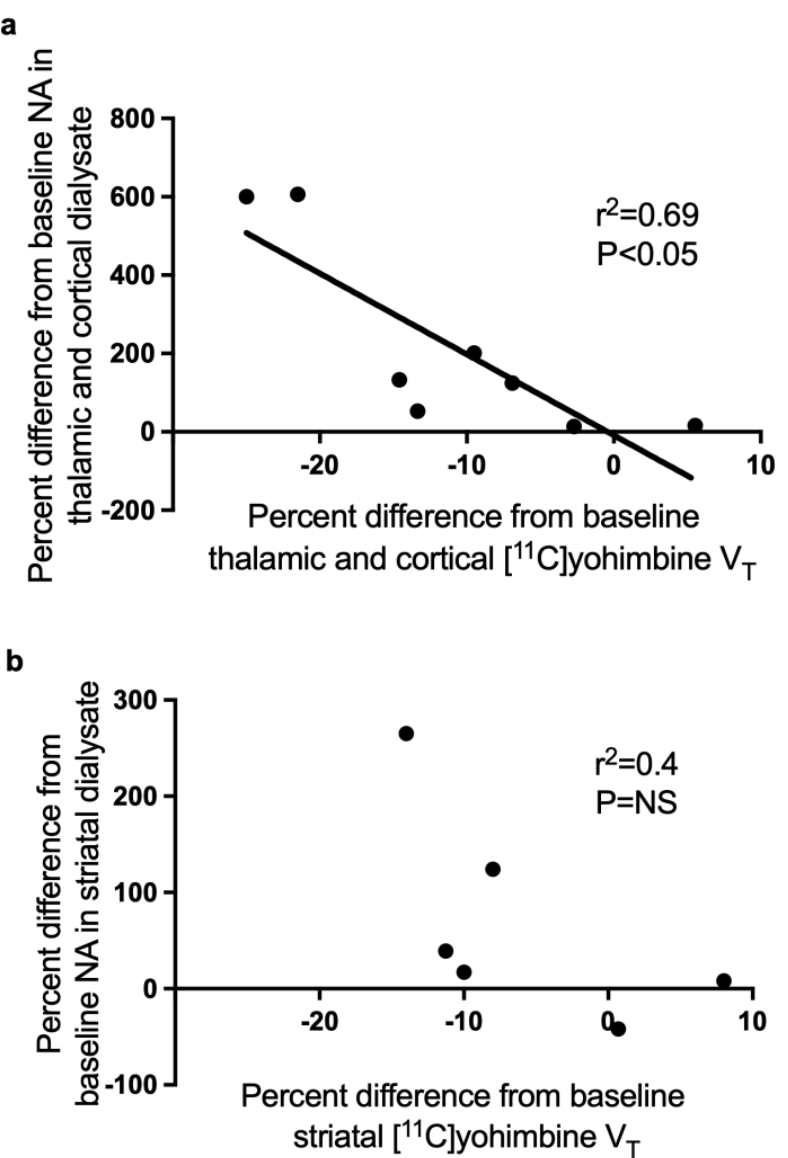
Figure 6. Correlations between the variations in extracellular NA and yohimbine V T . Data are ex- pressed as percent changes from baseline in thalamus and cortex ( a ) and in striatum ( b ). Each point represents the average % change in dialysis vs. the average % change in PET for each condition (4 conditions) and each timepoint (2 time comparisons). There was a significant inverse correlation between extracellular NA and V T in regions of high NA innervation and pre-eminence of α2A postsynaptic receptors. This correlation is however absent in the striatum, a region of sparse NA innervation.